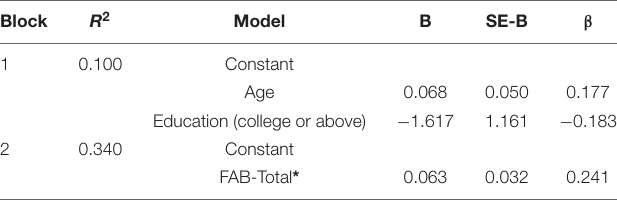
TABLE 6 | Summary of hierarchical regression model predicting of Roland Morris Disability Questionnaire